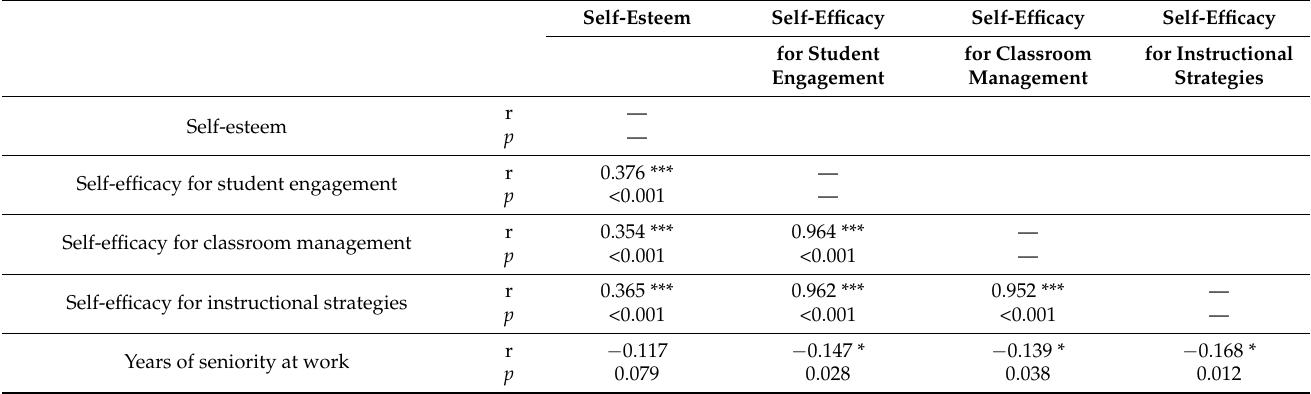
Table 3. Linear correlations between years of seniority, self-esteem and self-efficacy